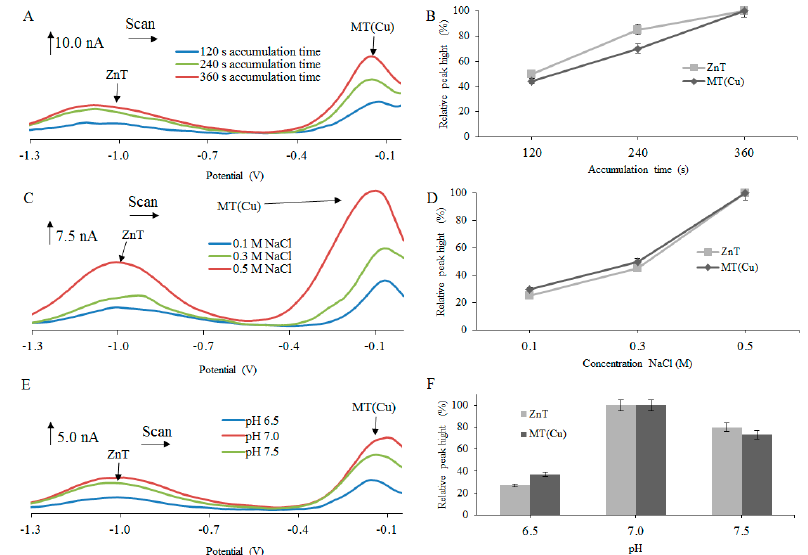
Figure 3. DP voltammograms of 2 µM human MT2A protein (hMT2A) from blood measured in different ( A ) accumulation times, ( C ) concentration of NaCl, and ( E ) pH. AdTS DPV parameters were as follows: initial potential − 1.5 V, end potential 0.0 V, modulation time 0.057 s, time interval 0.2 s, step potential of 1.05 mV/s, modulation amplitude of 25 mV. Dependences of heights of ZnT and MT(Cu) signals on ( B ) accumulation times of 120, 240, 360 s; ( D ) concentration of electrolyte (0.1, 0.3, 0.5 M); and ( F ) pH (6.5, 7.0, 7.5), expressed in relative percentage peaks and peak height